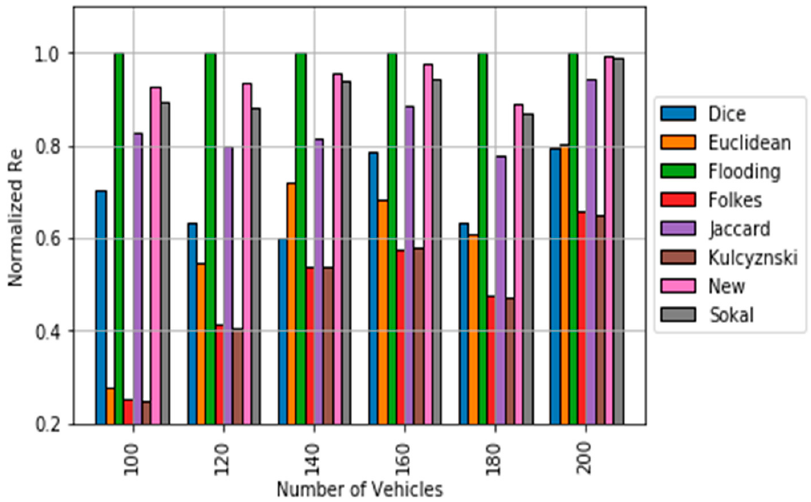
Figure 6. Comparison of Reachability results for the p-persistence scheme based on the different dissimilarity metric.